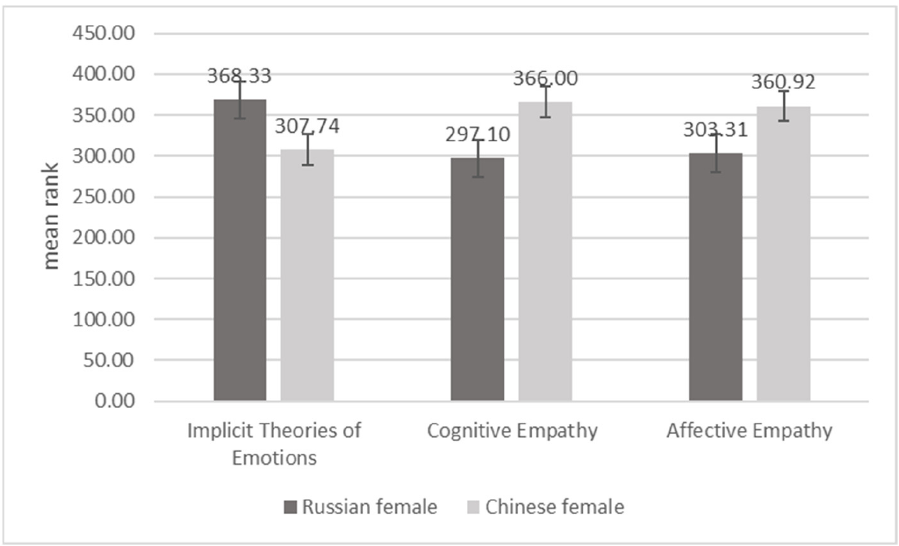
Figure 2. Differences between Russian and Chinese women on implicit theories of emotions, cognitive empathy, and affective empathy.